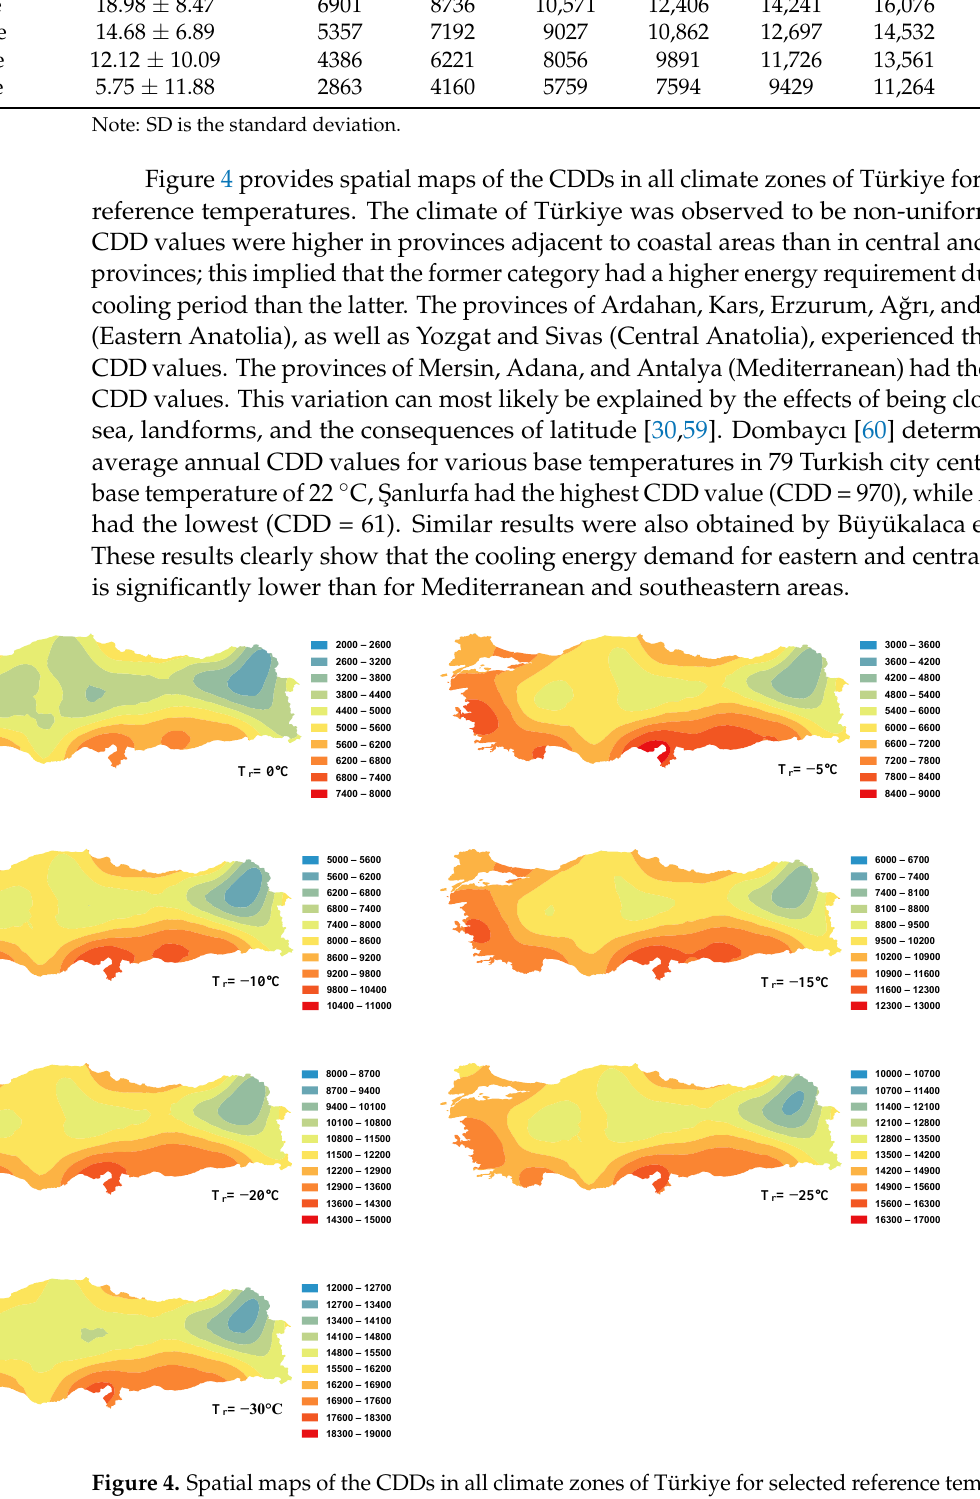
Figure 4. Spatial maps of the CDDs in all climate zones of Türkiye for selected reference temperatures (each of the maps has its own legend).